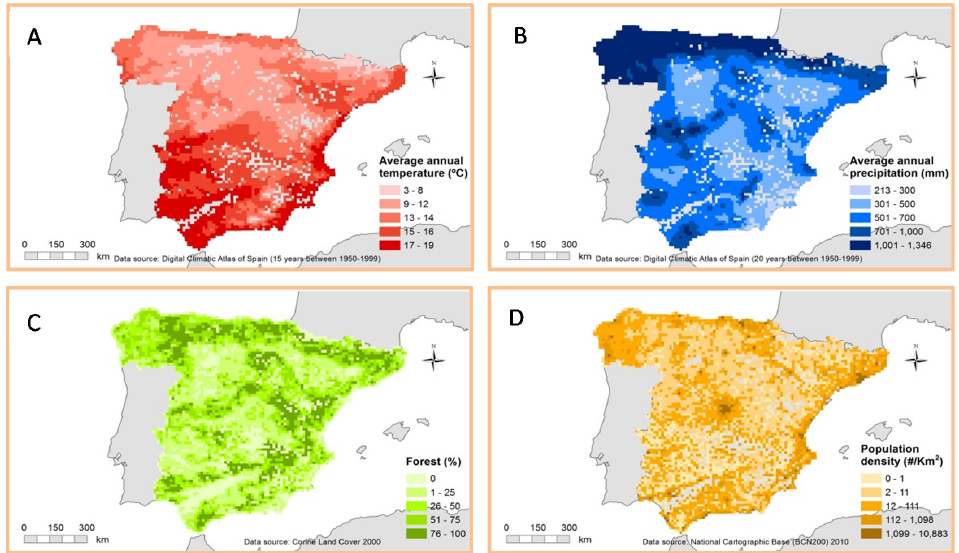
Figure 1. Spatial distribution over the study area of the average annual temperature (°C) ( A ) and the average annual precipitation (mm) ( B ) from the Digital Climatic Atlas of Spain [31] (20 and 15 years between 1950–1999, respectively), the population density (inhabitants/km 2 ) ( D ) from the National Cartography Base (BCN200; 2010) and the forest land cover (%) ( C ) from the Corine Land Cover 2000 map.